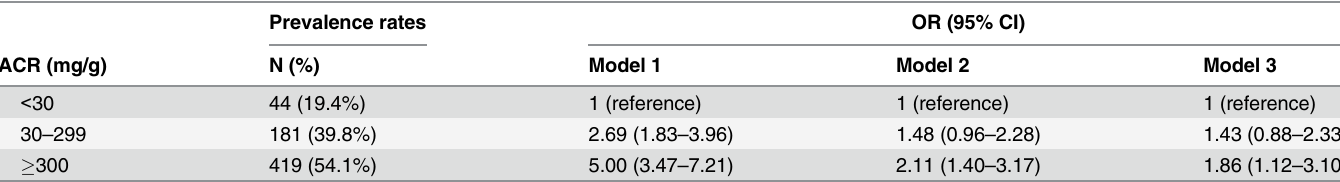
Table 2. Odds ratios for anemia associated with